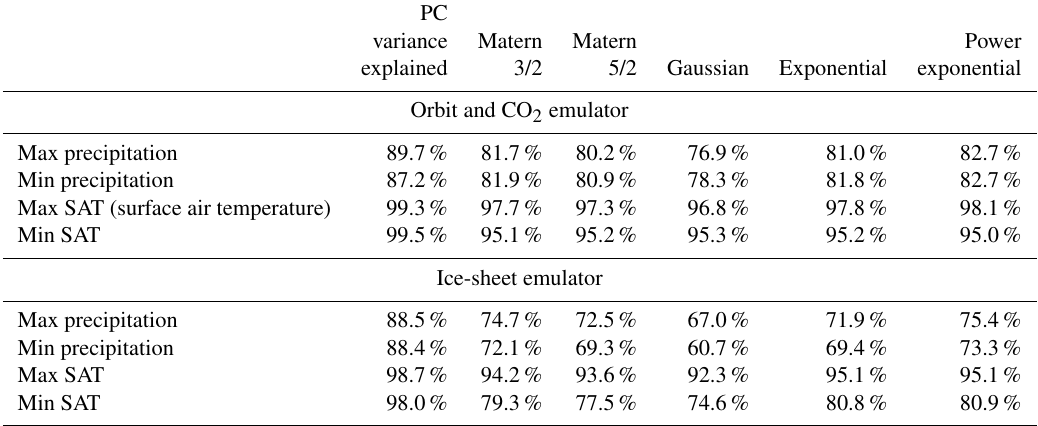
Table 3. Optimization of the Gaussian process covariance function. The variance explained by the first 10 components of the decomposition is quantified by “PC variance explained”, which would be the expected variance explained if the emulators were perfect. The percentage of variance explained by the emulators is quantified by the metric P (Eq. 3, including 10 components) for each of the eight emulators, considering various tested covariance functions. A power exponential is favoured for the final emulator, having similar average performance to exponential covariance function but outperforming it for the more difficult precipitation variables.